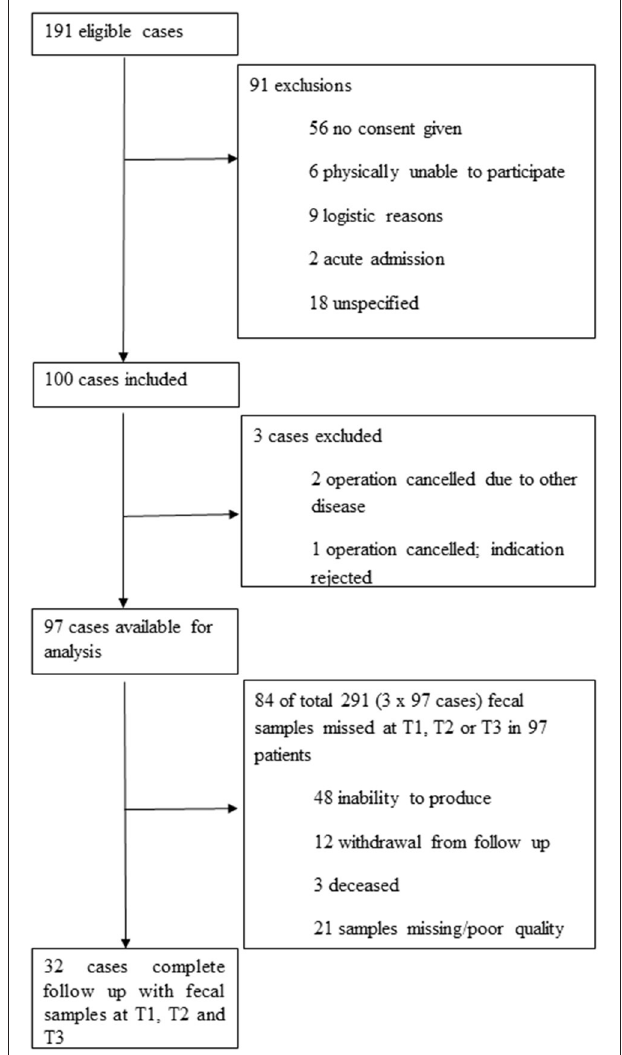
FIGURE 1 | Patient and sample